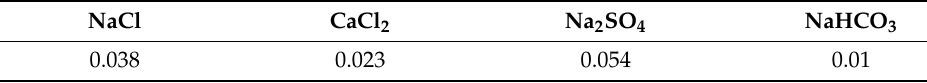
Table 3. Composition of the simulated acidic soil solution (g · L − 1 ).